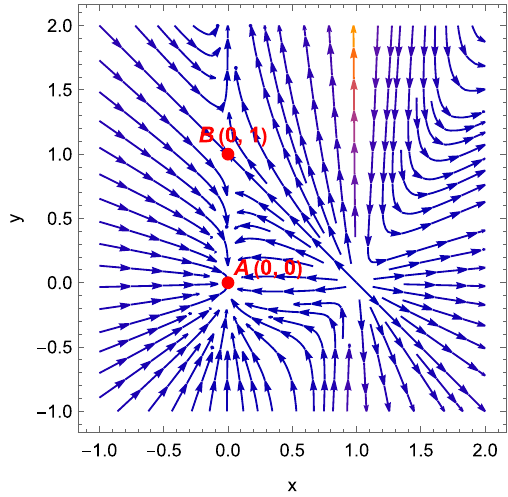
Fig. 3 Phase-space trajectories on the x - y plane for f ( Q ) gravity